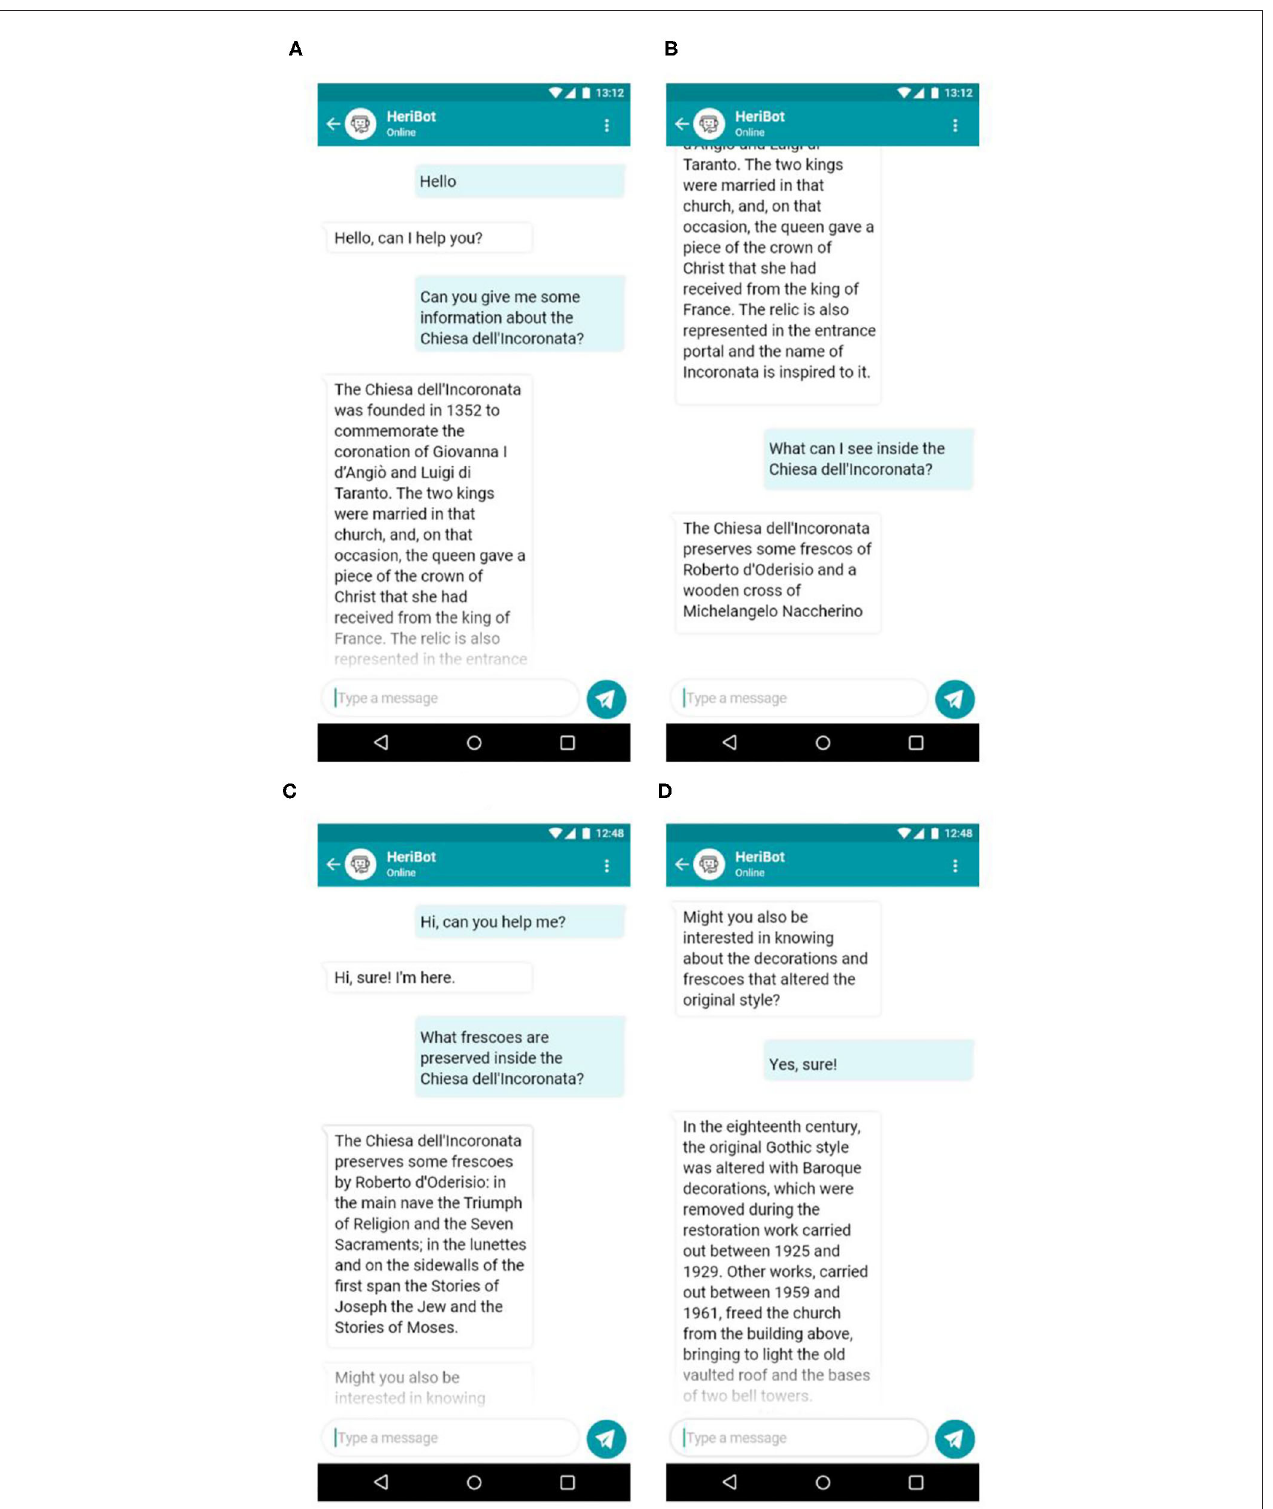
FIGURE 8 | The figure reports examples of dialogues related to two categories of users. In the first example (A,B) , HeriBot communicates with a non-expert user, i.e., a tourist, providing general information about the Chiesa dell’Incoronata (Church of Incoronata), an asset located within the PAUN. In the second case (C,D) , HeriBot interacts with an expert user about the Church of Incoronata, providing more technical